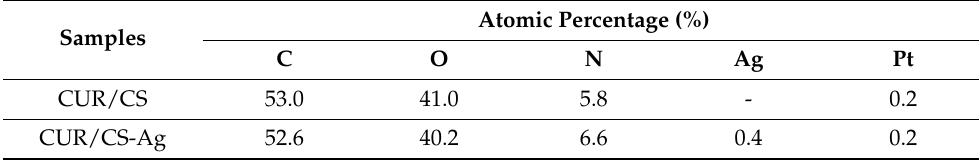
Figure 2. Schematics of the possible chemical interactions between curdlan and chitosan. Table 1. Atomic percentage (%) from energy dispersive X-ray (E.D.X.) element mapping.